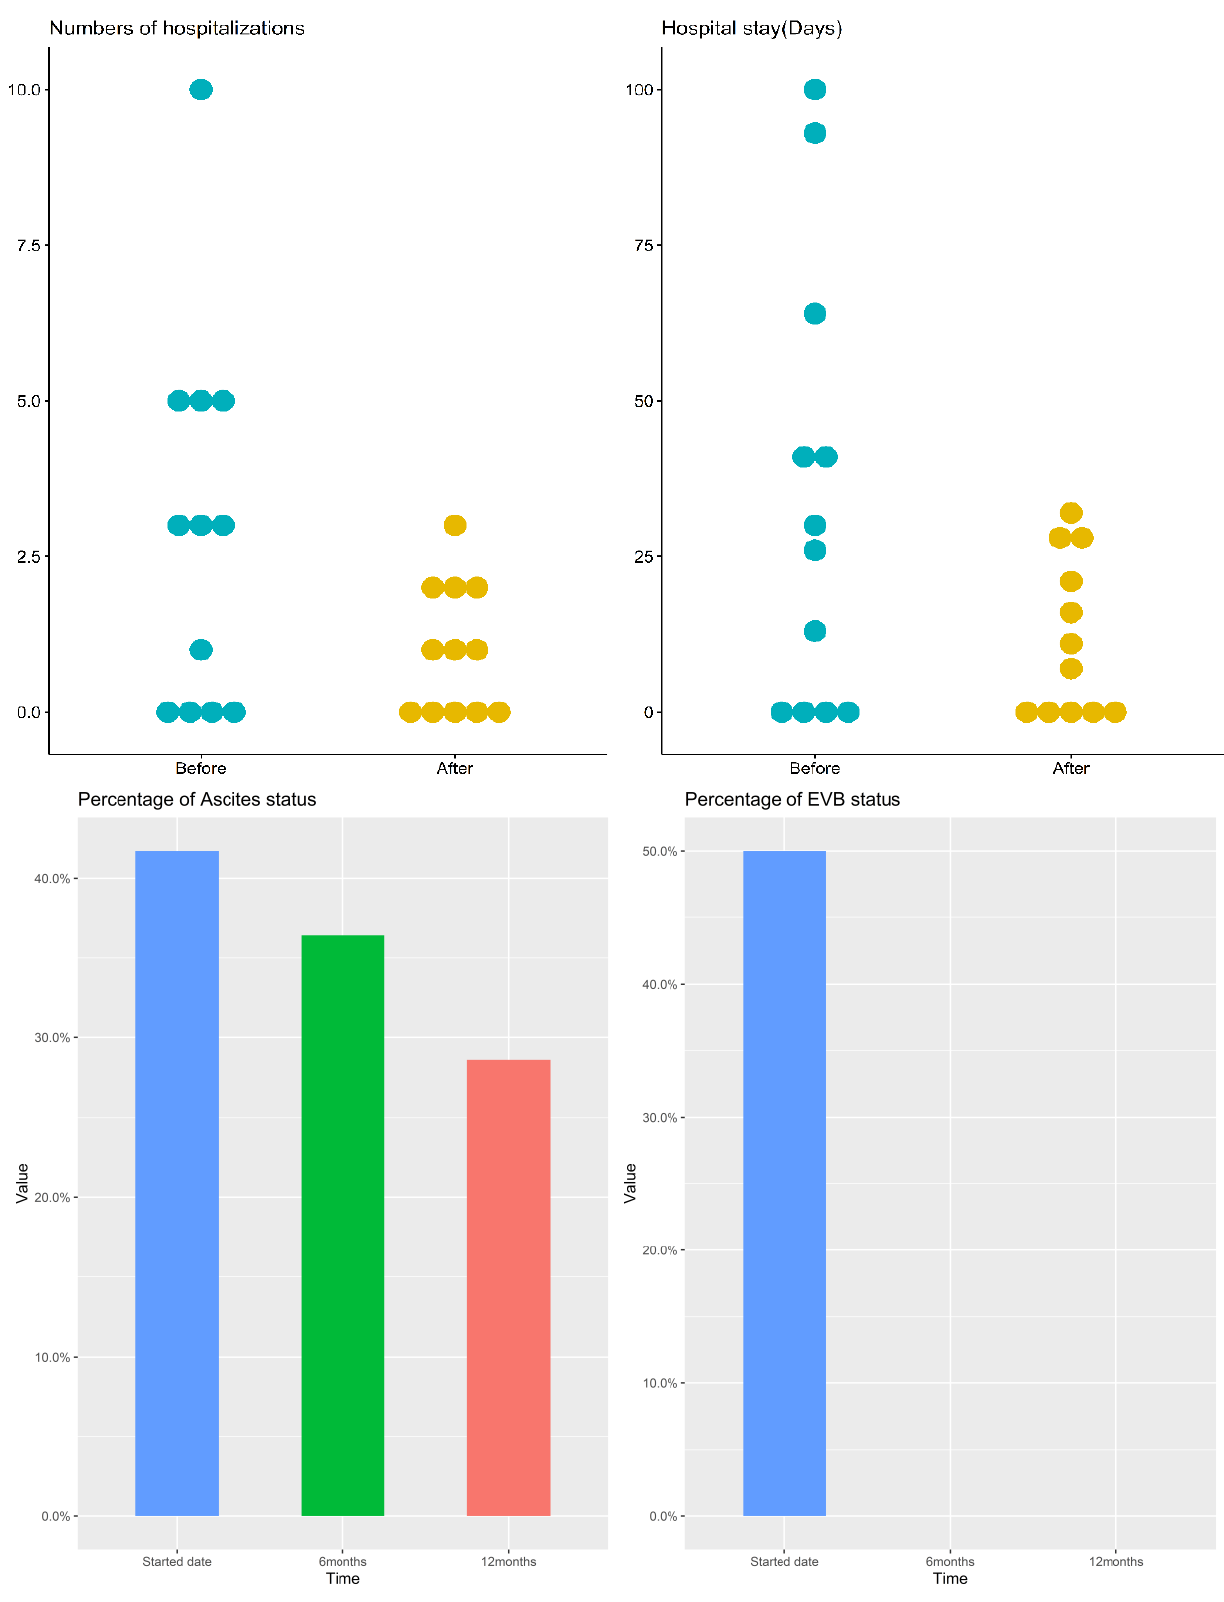
Figure 3. Display of important clinical and laboratory parameter changes in Group 1 patients during different follow-up time points.